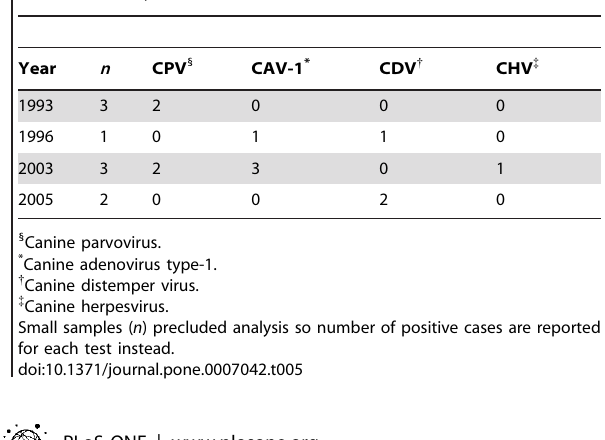
Table 5. Summary of red fox serological results, Yellowstone National Park,